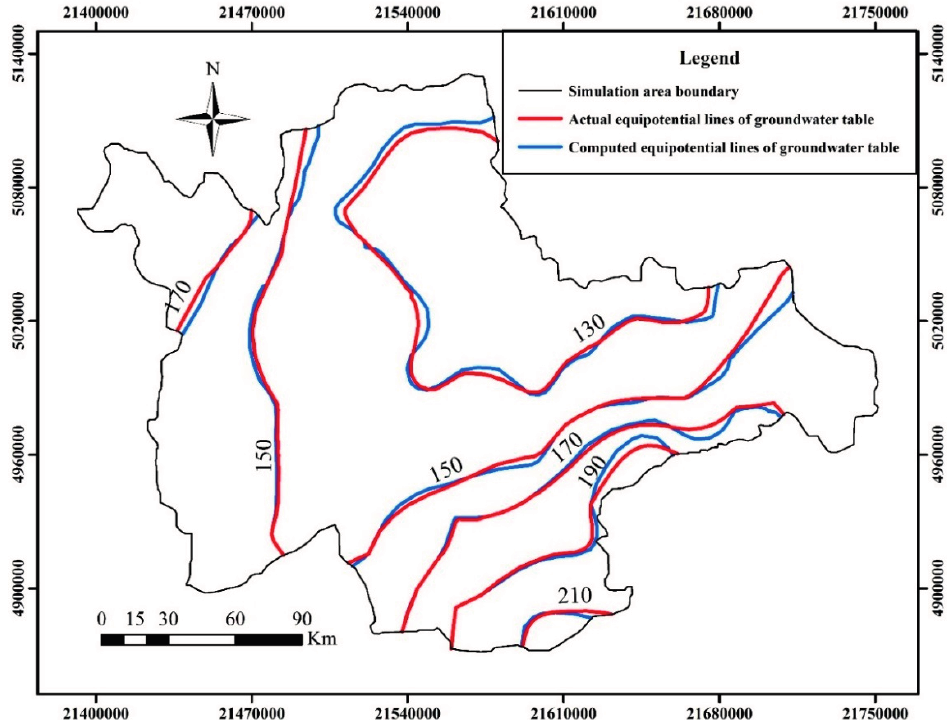
Figure 6. The actual and computed equipotential lines of groundwater table at the end of the model calibration